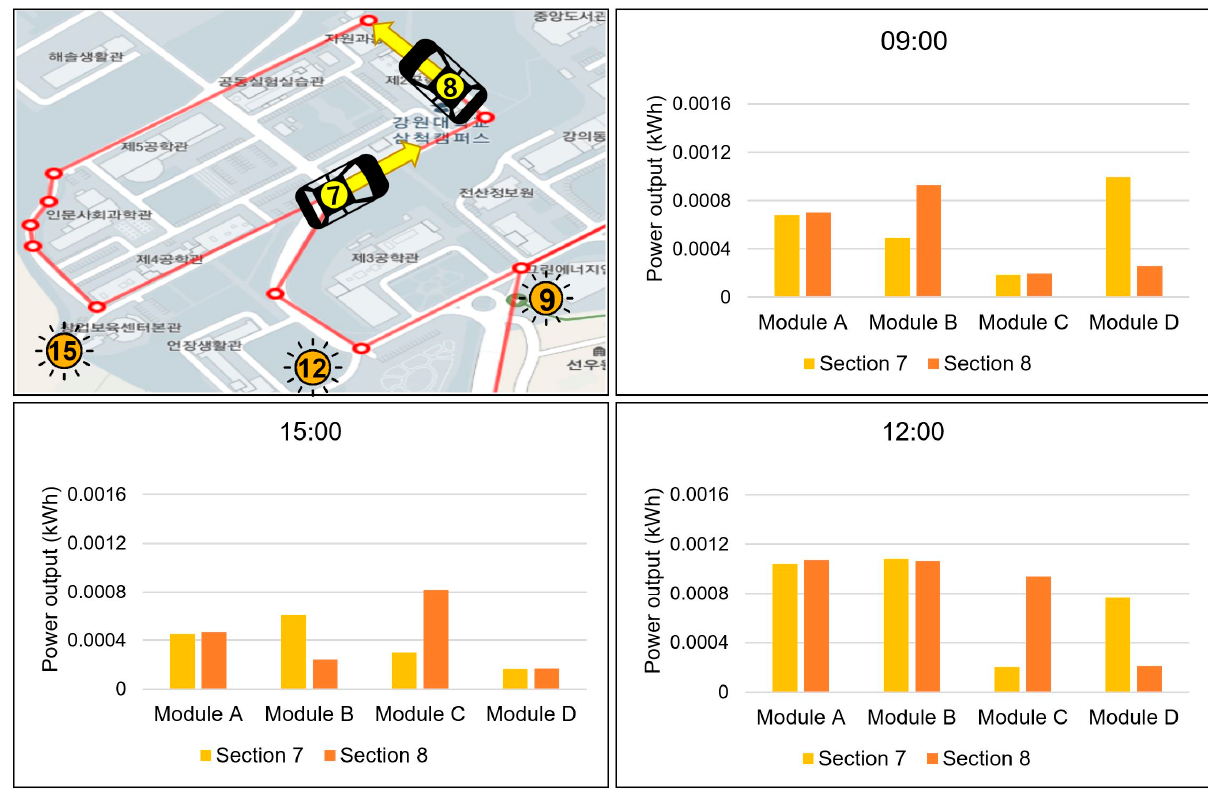
Figure 10. Comparison of PV potential by time between sections 7 and 8 in different azimuth (Korean labels in the map indicate the building name).